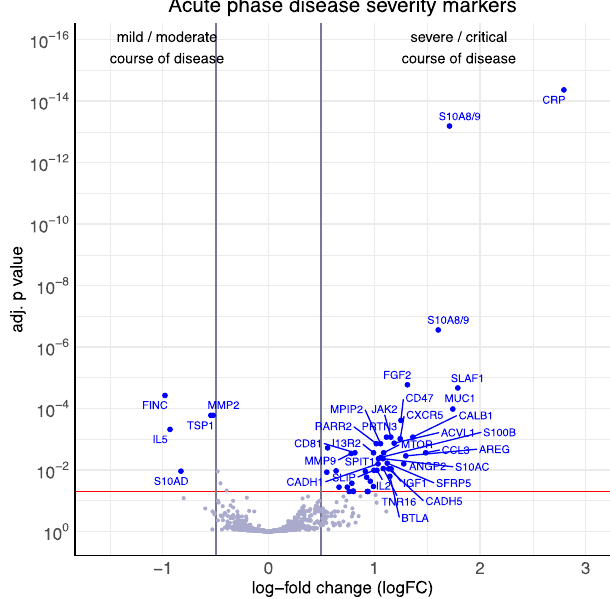
Fig. 4 Protein biomarker candidates from the 2 nd cohort to predict a severe or critical disease in acute phase. Plasma samples from 94 COVID- 19 patients during the acute phase of disease were analyzed on antibody microarrays to identify differentially abundant proteins between patients with either a mild or moderate (MM, n = 47) or a critical or severe (CS, n = 47) disease course. The volcano plot visualizes the p values and corresponding log-fold changes (logFC). A signi fi cance level of adj. p value = 0.05 is indicated as a horizontal red line. Absolute logFC cutoffs of |logFC | > 0.5 are indicated as vertical lines. Proteins with a positive logFC had a higher abundance in CS samples, proteins with a negative value in MM samples. Two different antibodies against S10A8/A9 were included on the microarray, with both antibodies showing signi fi cant differences between CS and MM